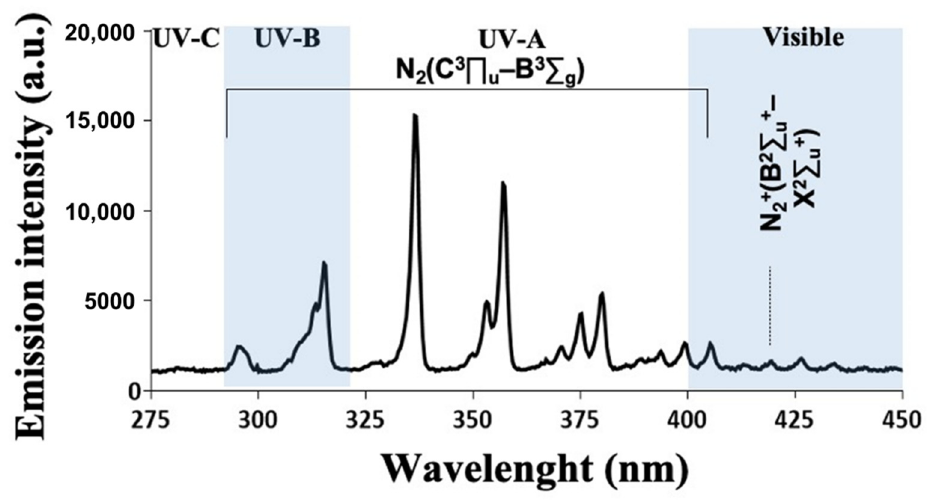
Figure 3. Optical emission spectrum of a cold atmospheric plasma jet obtained 5 mm away from the nozzle exit, over the range of selected wavelengths from 275 to 450 nm. Emission lines identify the particles and radicals produced.